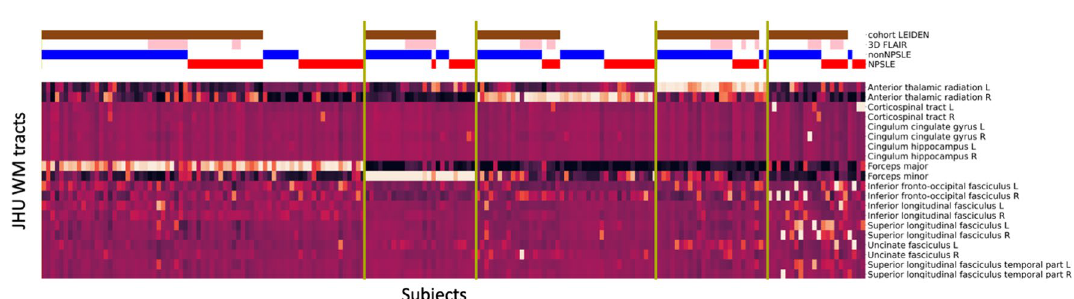
Figure 7. Sensitivity Analysis using GLM. Cluster analysis on the entire SLE cohort performed after L2 normalization and GLM model to correct for cohort, type of FLAIR, sex, age, disease duration. SDI-score, SLEDAI-2 k-score and WMH total volume. The horizontal bars at the top show additional information: Leiden cohort (brown) complemented by the Lund cohort, 3D-FLAIR (pink) complemented by 2D-FLAIR, non- NPSLE (blue), NPSLE (red). GLM, General linear model; FLAIR, Fluid-attenuated inversion recovery; NPSLE, Neuropsychiatric systemic lupus erythematosus; SDI, Systemic lupus international collaborating clinics damage index; SLEDAI-2 K, Systemic lupus erythematosus disease activity index